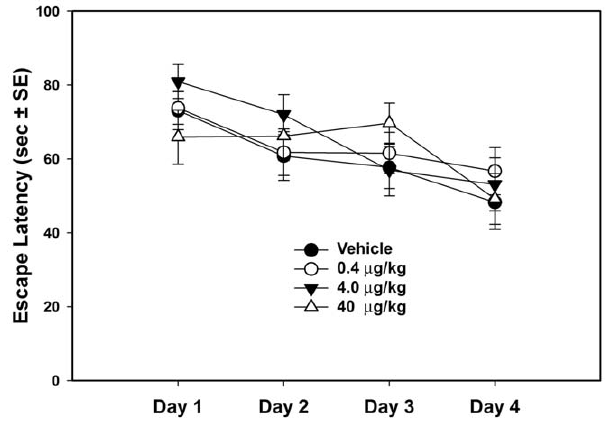
Figure 3. Mean escape latency in the Morris water maze for the four treatment groups. No group differences were statistically